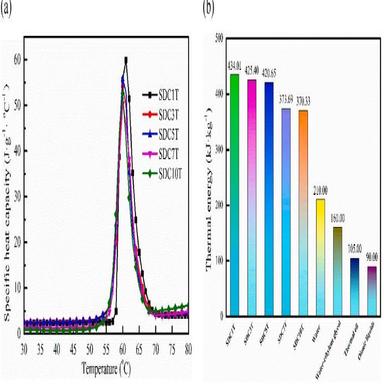
The specific heat capacity and the thermal energy storage densities of SDC with different Ti4O7 and other sensible heat materials.